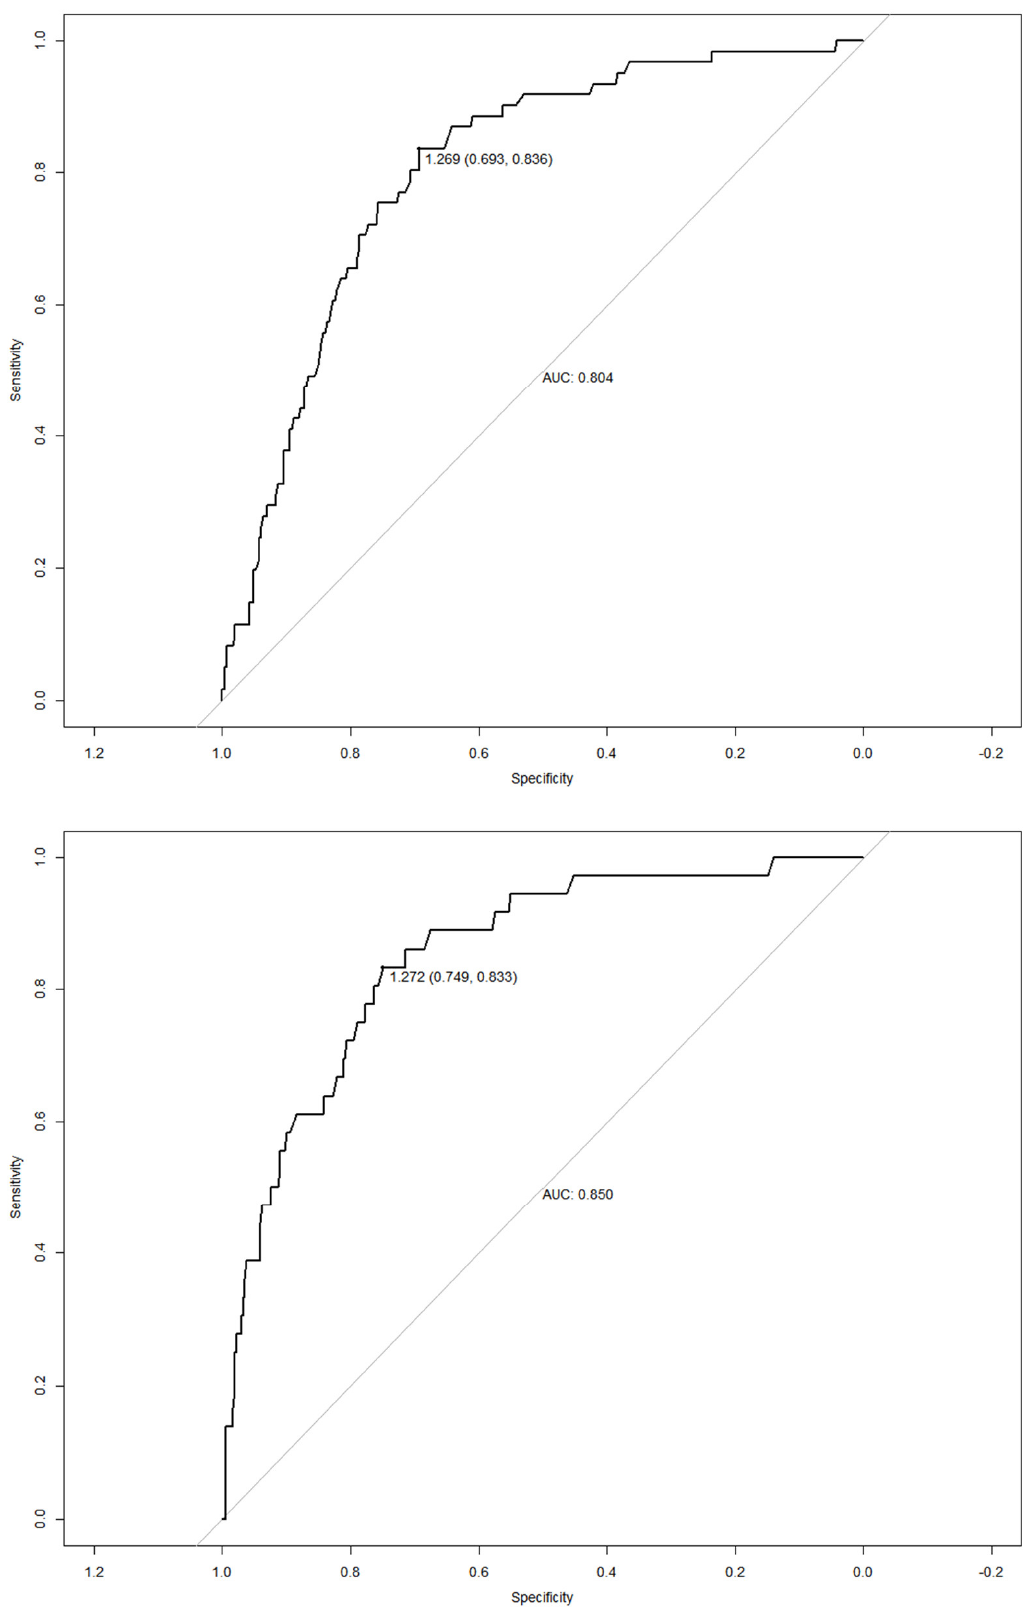
Figure 1. ROC curves of the conicity index for the diagnosis of abdominal obesity in female and male Brazilian rural workers according to the NCEP − ATP III criteria, respectively. AUC—area under the curve.